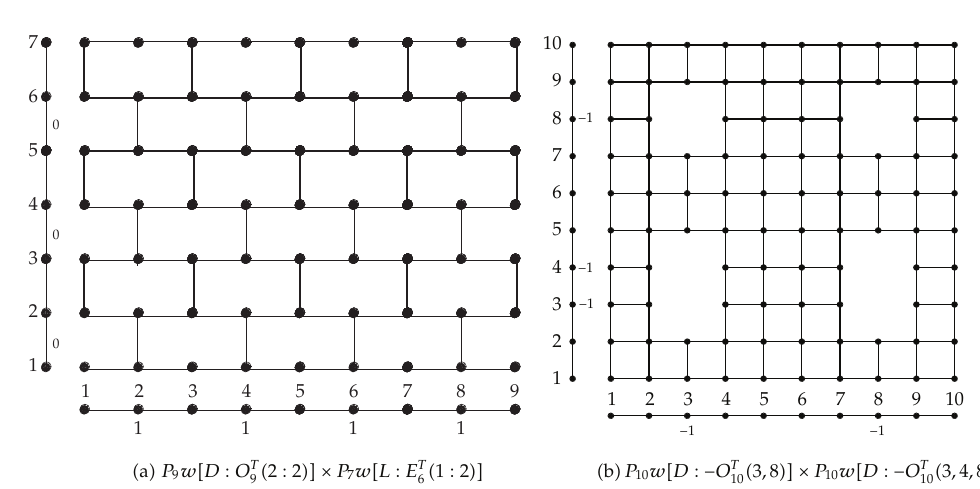
Figure 5: Examples of two weighted Cartesian